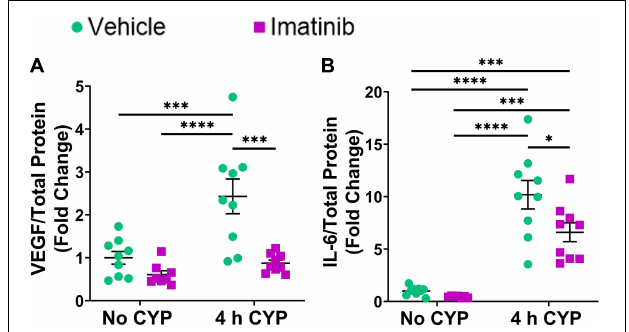
FIGURE 3 | Oral gavage of imatinib mesylate significantly decreases inflammatory mediator protein expression the urinary bladder in an acute (4 h) cyclophosphamide (CYP)-induced cystitis female mouse model. Acute (4 h) CYP treatment (200 mg/kg, i.p.) significantly (0.0001 ≤ p ≤ 0.001) increased (A) VEGF (2.4-fold) and (B) IL-6 (10.2-fold) whole bladder protein expression in female mice pre-treated with vehicle (water) via gavage, compared to vehicle (water gavage, no CYP) control. Imatinib prevention (250 mg/kg, 5 days, 1X/day) via oral gavage significantly (0.001 ≤ p ≤ 0.05) decreased (A) VEGF (2.8-fold) and (B) IL-6 (1.5-fold) whole bladder protein expression in female mice with 4 h CYP-induced cystitis. Sample values for CCL2